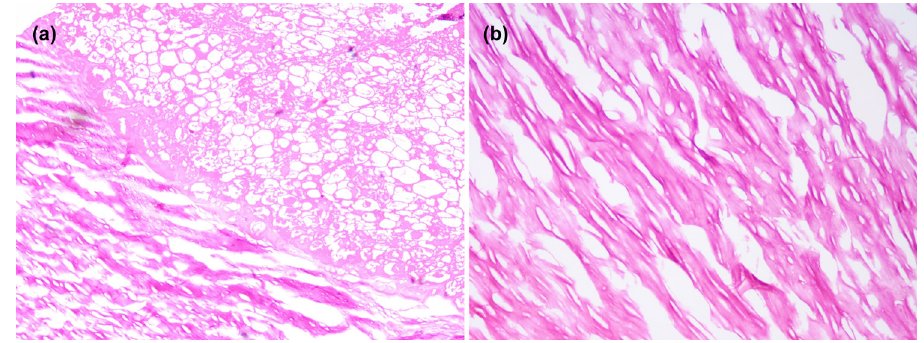
Figure 3: Photomicrograph shows ( a ) the necrotic and mechanized adipose tissue in the center of the free body, and its periphery surrounded by dense connective tissue and ( b ) the dense collagen connective tissues around the central degenerated region arranged in concentric circles. ( hematoxylin and eosin, a × 40 and b × 100 original magni fi cation